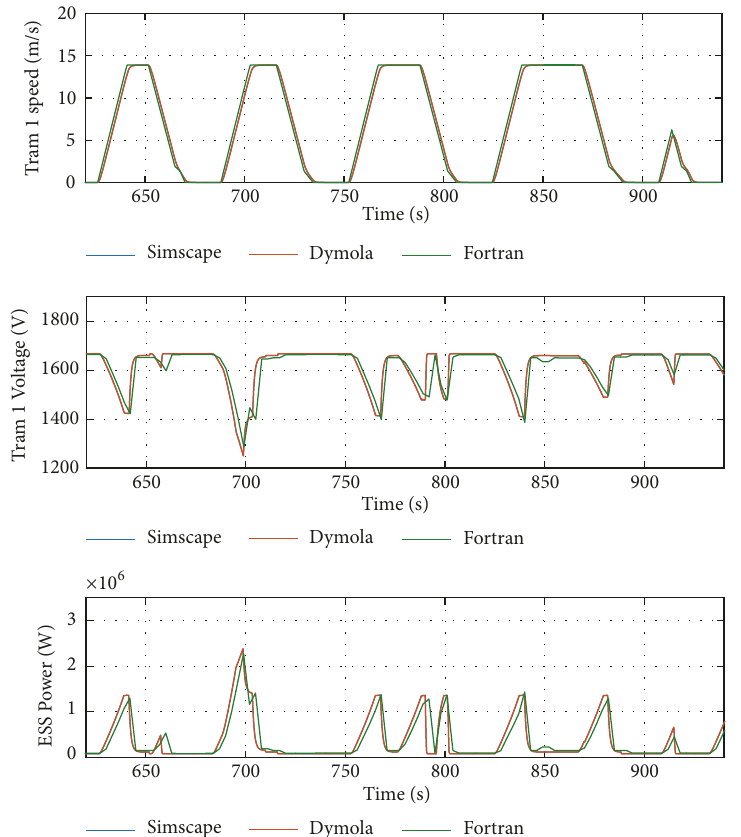
Figure 5: Plot results, trams without braking energy recovery.